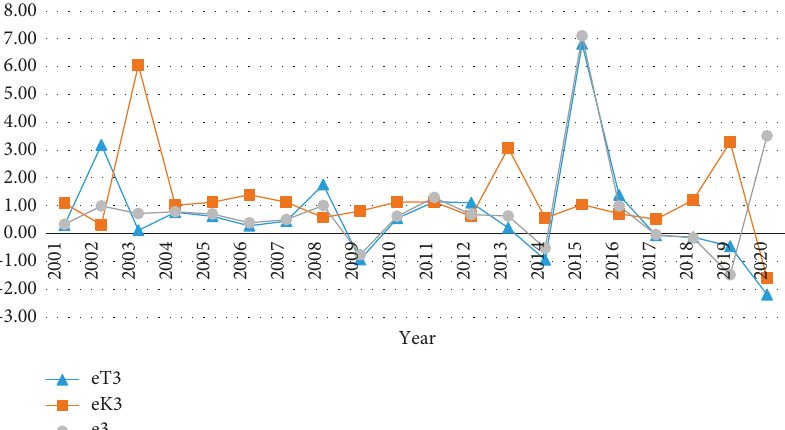
Figure 16: Relationship between carbon emission decoupling index and intermediate variables of the ferrous metal sector from 2001 to